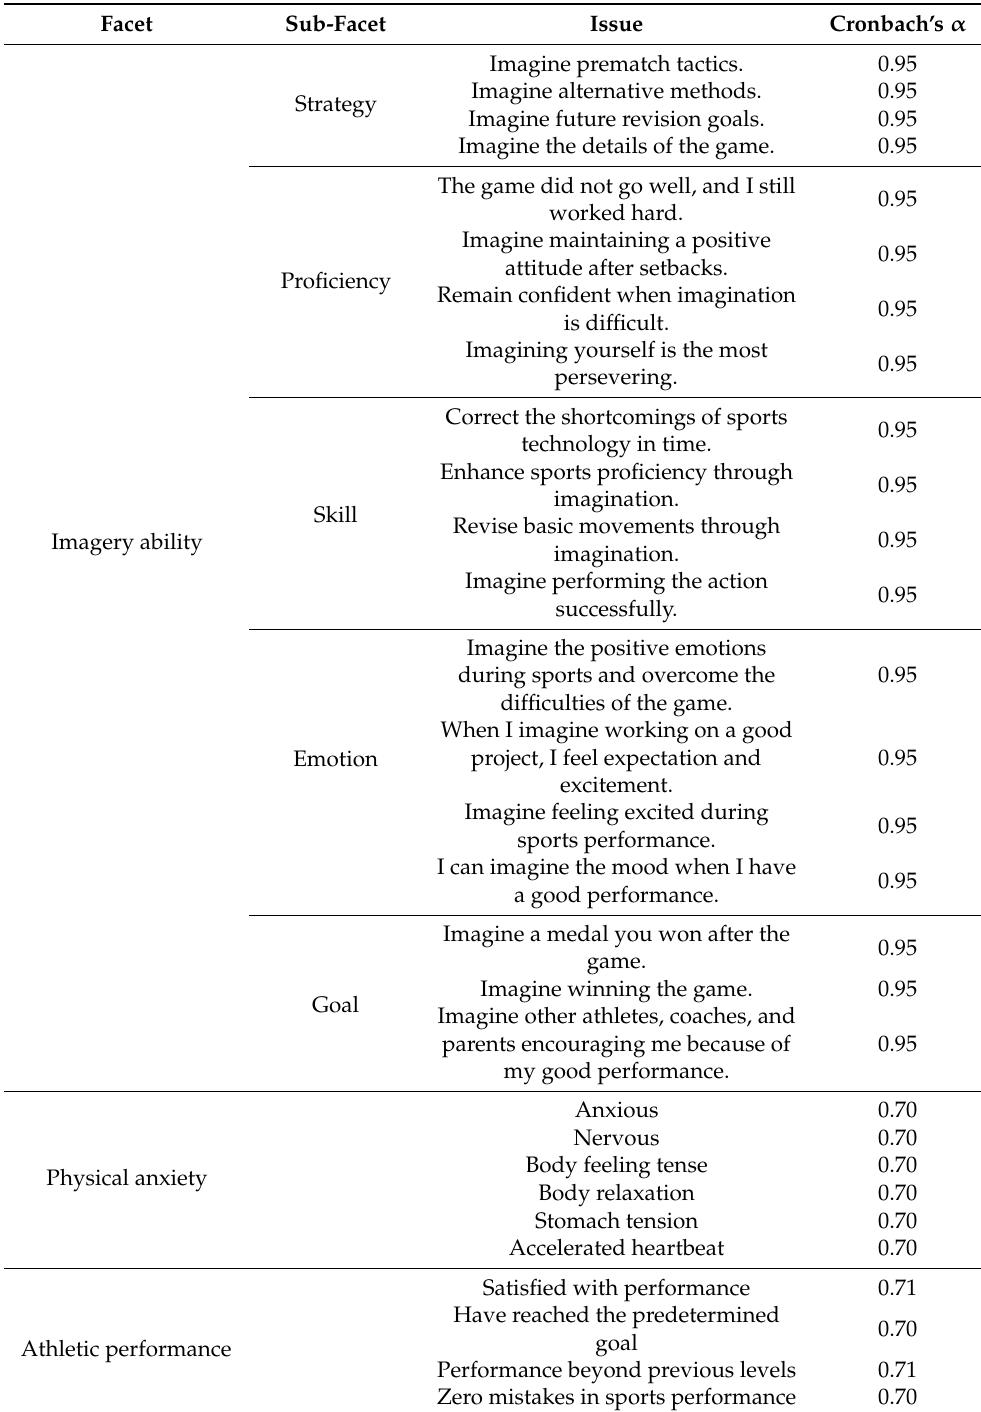
Table 2. Validity analysis of